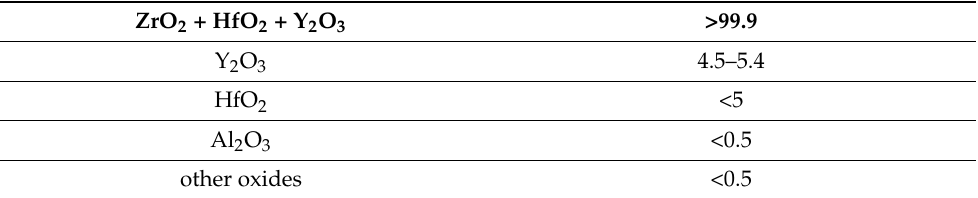
Table 1. Composition of the tested material (according to the manufacturer’s